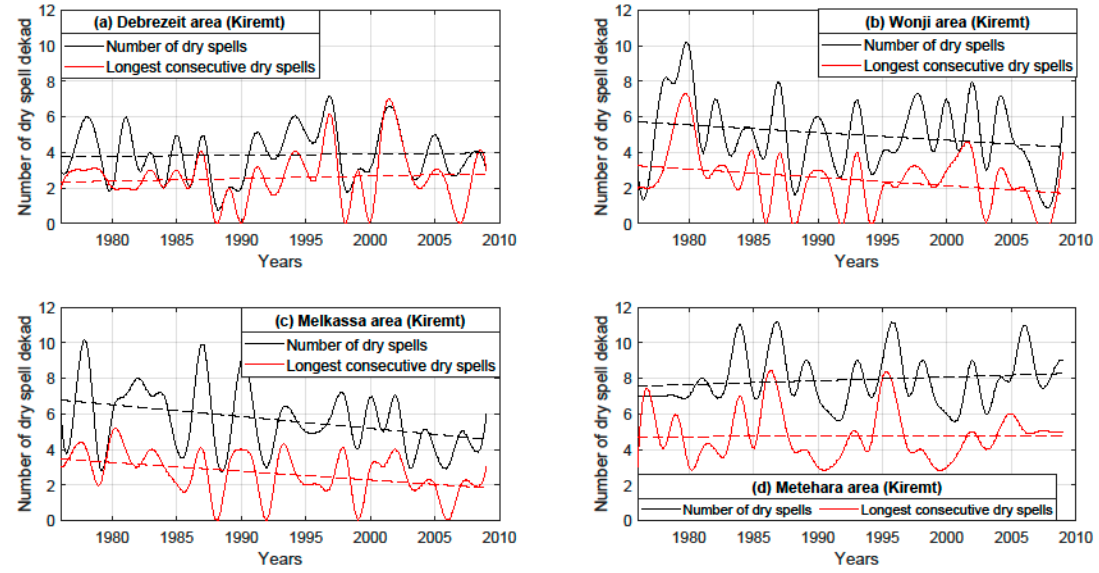
Figure 3. Temporal trends of dry spell patterns in the Kiremt season.